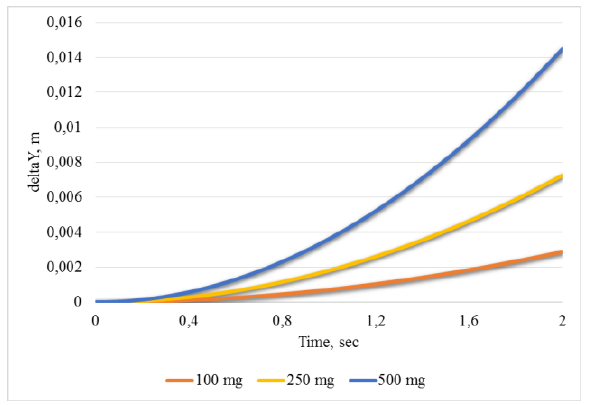
Figure 9. Accelerometers errors accumulation along Y axis